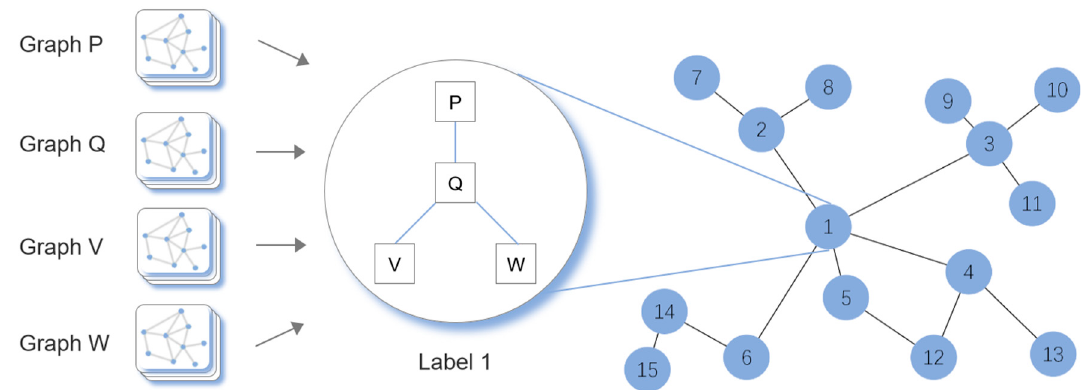
Figure 3. Diagram of LZ-GCN; the numbered circles indicate labels.